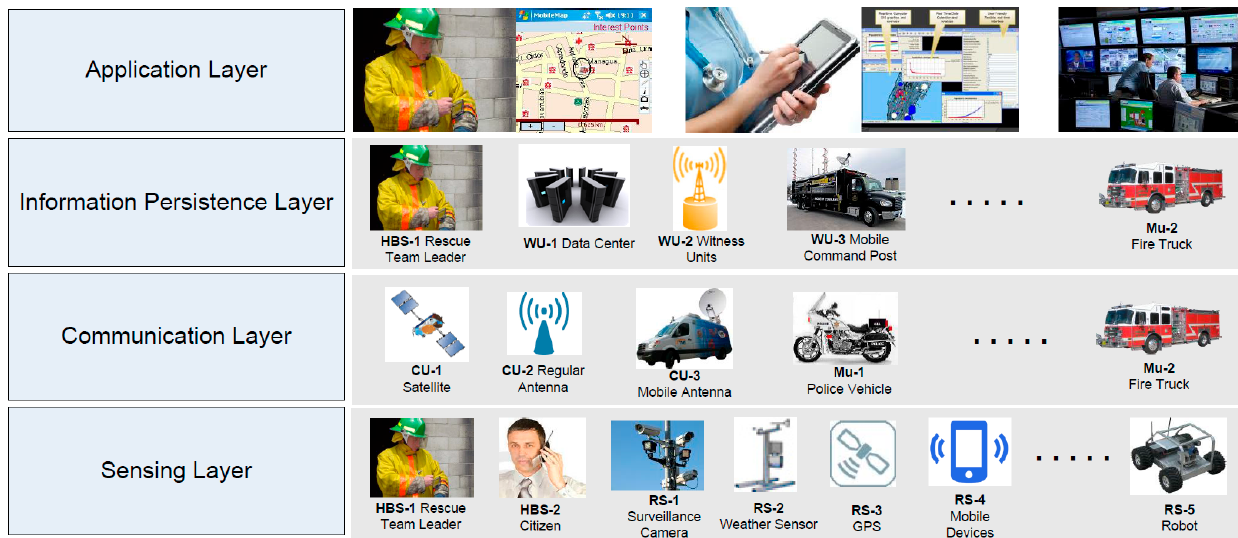
Figure 6. Hierarchy of architectural